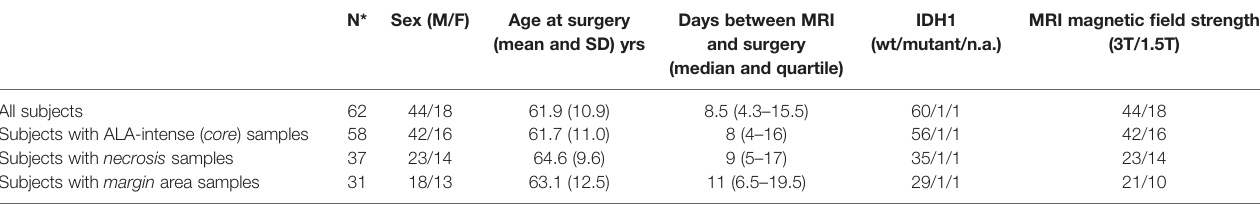
TABLE 1 | Demographic data and clinical variables of the study